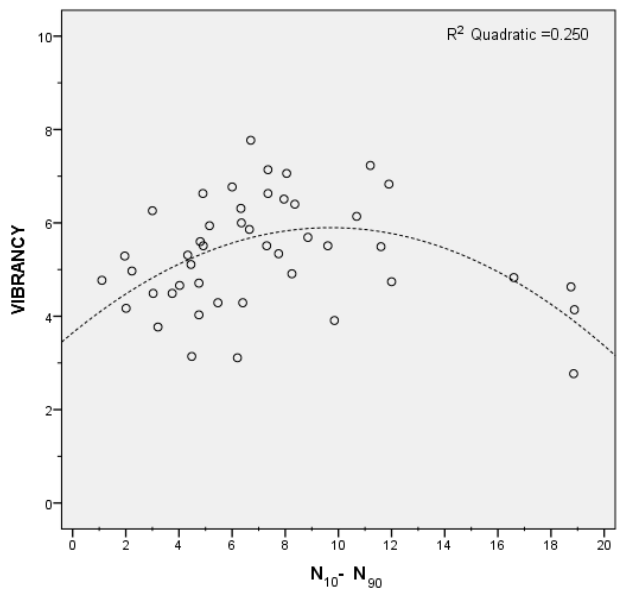
Figure 8. Scatter plot of the loudness variability (N 10 –N 90 ) values vs. the mean vibrancy scores.